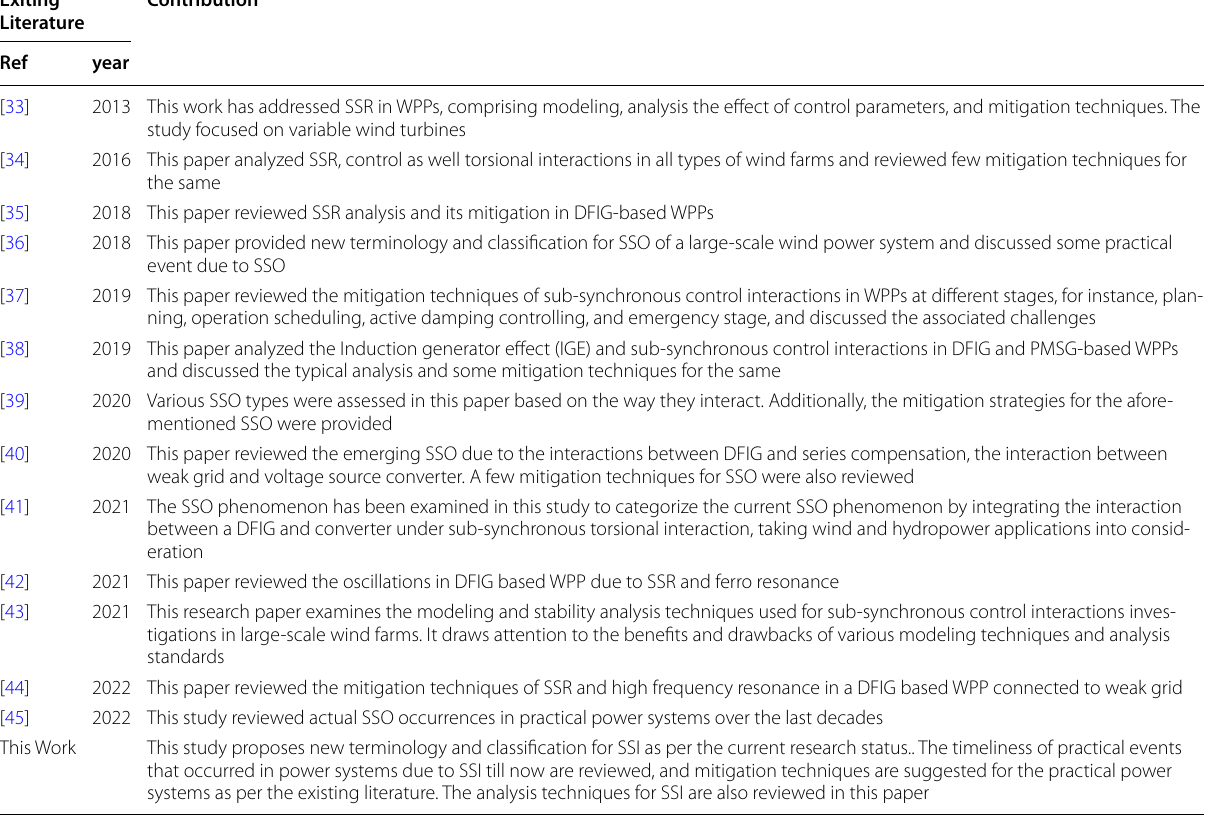
Table 1 Timeliness of the state-of-the-art review paper on SSI Exiting